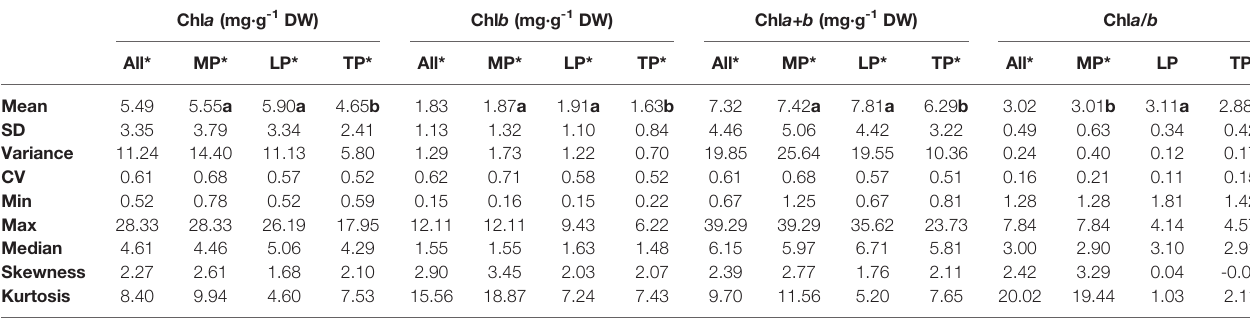
TABLE 2 | Eigen-values of frequency distributions of chlorophyll concentrations by dry weight (DW) and ratio grouped by regions. Chl a (mg·g -1